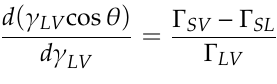
Figure 5. Schematic models of surfactant molecules of SDS, DTAB, N-200, N-300, Tween-80, and Morwet EFW adsorbed at the tea leaf surfaces.